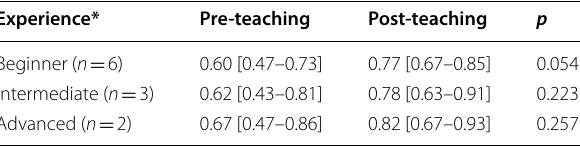
* Experience was stratified as: beginner (< 50 prostate MR scans reported), intermediate (between 50 and 100 prostate MR scans reported) and advanced (> 100 prostate MR scans